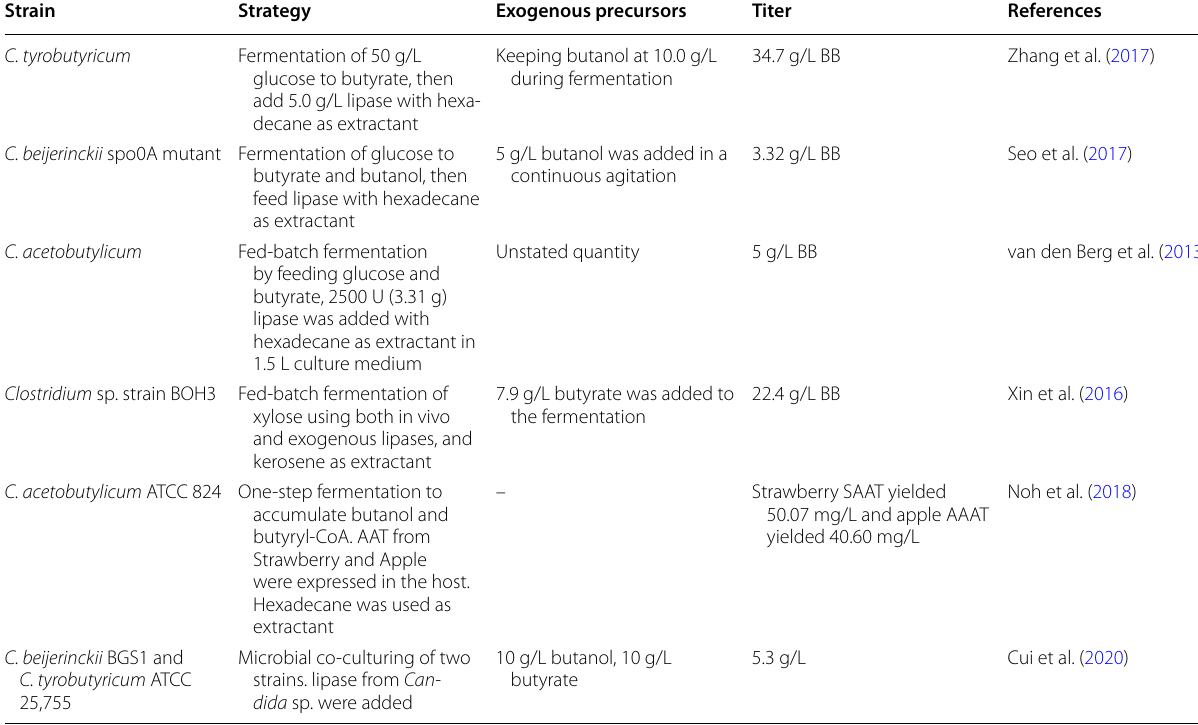
Table 1 Comparison of recent studies for microbial ester biosynthesis by Clostridia species